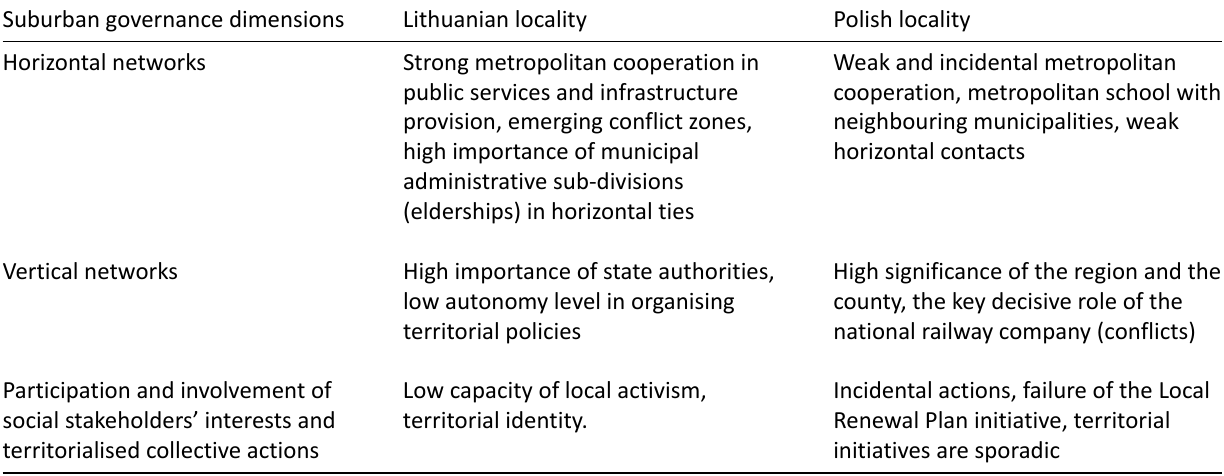
Table 3. Networks and governance processes—main characteristics of the case studies. Suburban governance